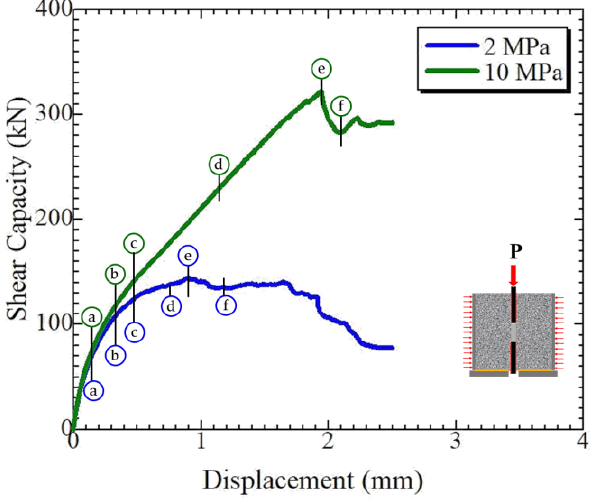
Figure 10. Representation of various stages for shear response evaluation.